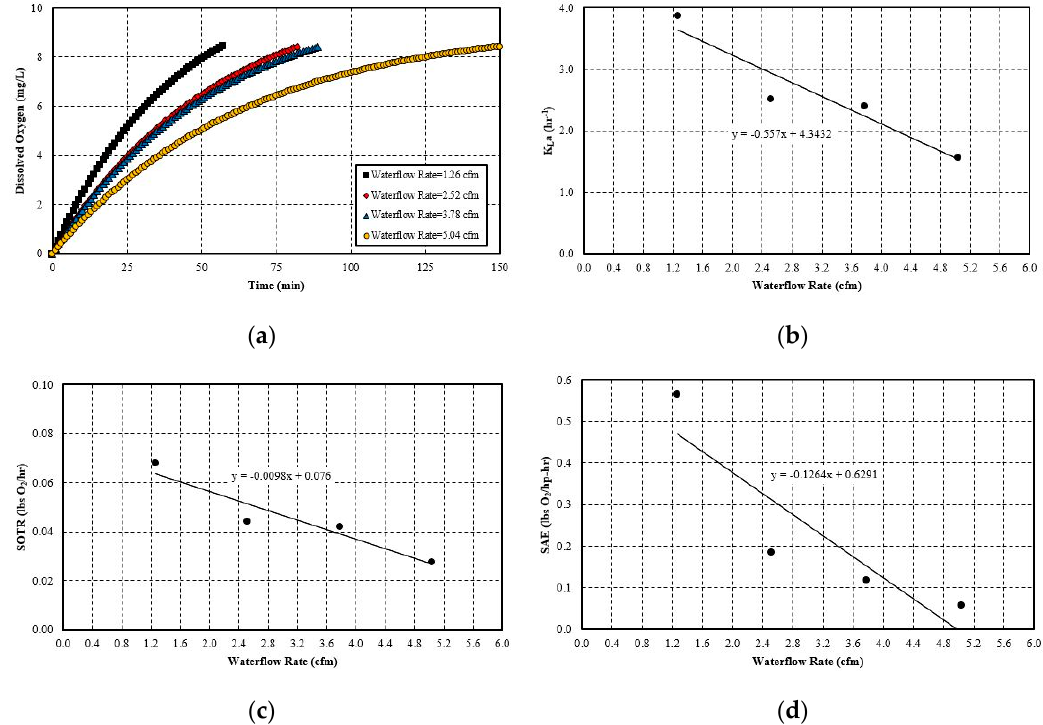
Figure 10. E ff ect of liquid rate on: ( a ) Dissolved (mg / L) oxygen vs. time (min); ( b ) K L a (h − 1 ); ( c ) SOTR Figure 10. Effect of liquid rate on: ( a ) Dissolved (mg/L) oxygen vs. time (min); ( b ) K L a (h − 1 ); ( c ) SOTR (lbs O 2 / h); ( d ) SAE (lbs O 2 / (lbs O 2 /h); ( d ) SAE (lbs O 2 /hp-h).